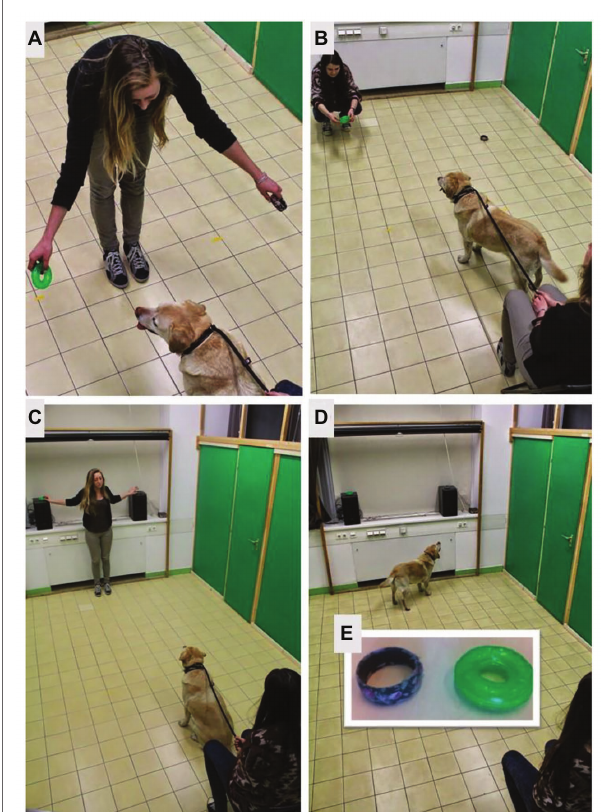
FIGURE 1 | (A) Object preference test, (B) demonstration by the owner, (C) object hiding in Study 2, (D) looking at the objects in Study 2, (E) test objects for all dogs: bracelet (left), toy (right), both 9 cm in diameter. The persons identifiable in the images provided written consent for the